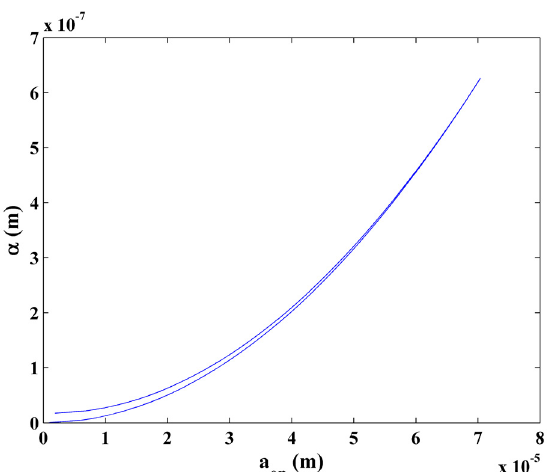
Fig. 4. plastic contact radius in terms of normal contact force.